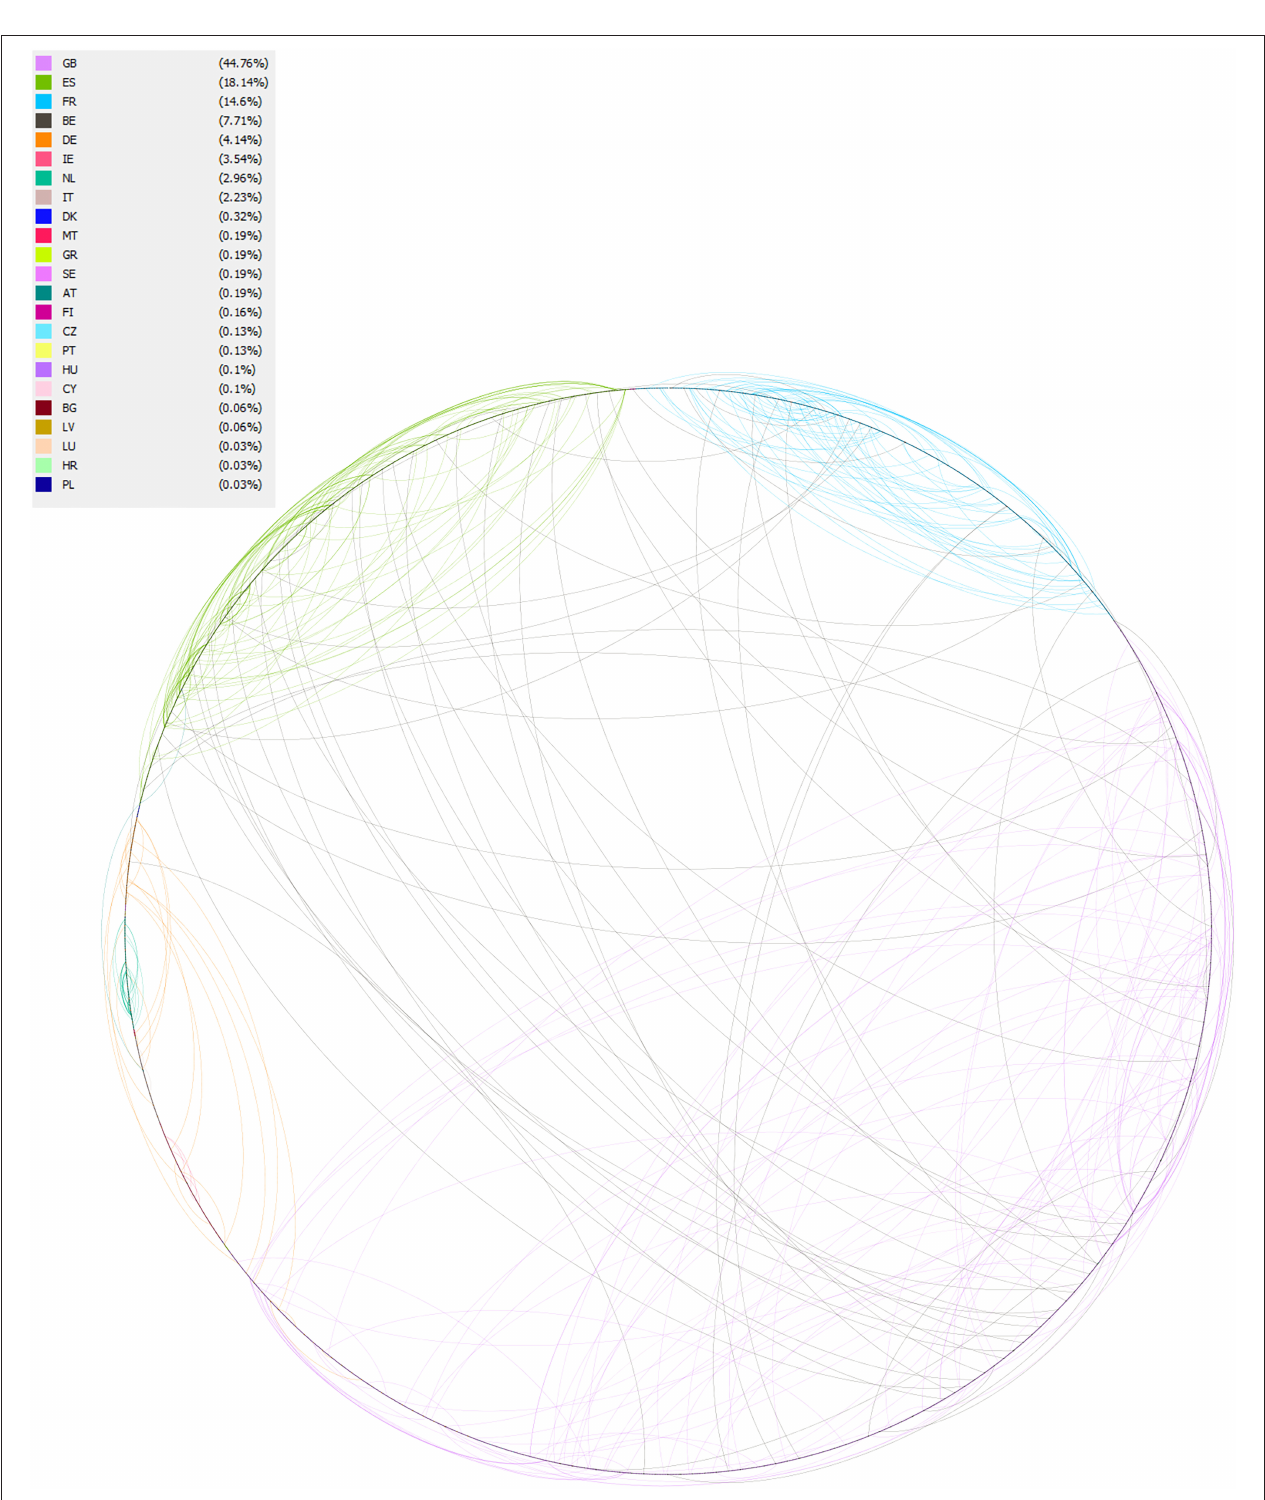
FIGURE 2 | Network analysis. The circumference of the circle shows the total amount of tweet data. The circumference is divided into segments, each color corresponds to a country and each dot is associated with their conversation ID. The segments are connected by chords that illustrate the relationship within/between countries. Each tweet relationship is symbolized by a separate